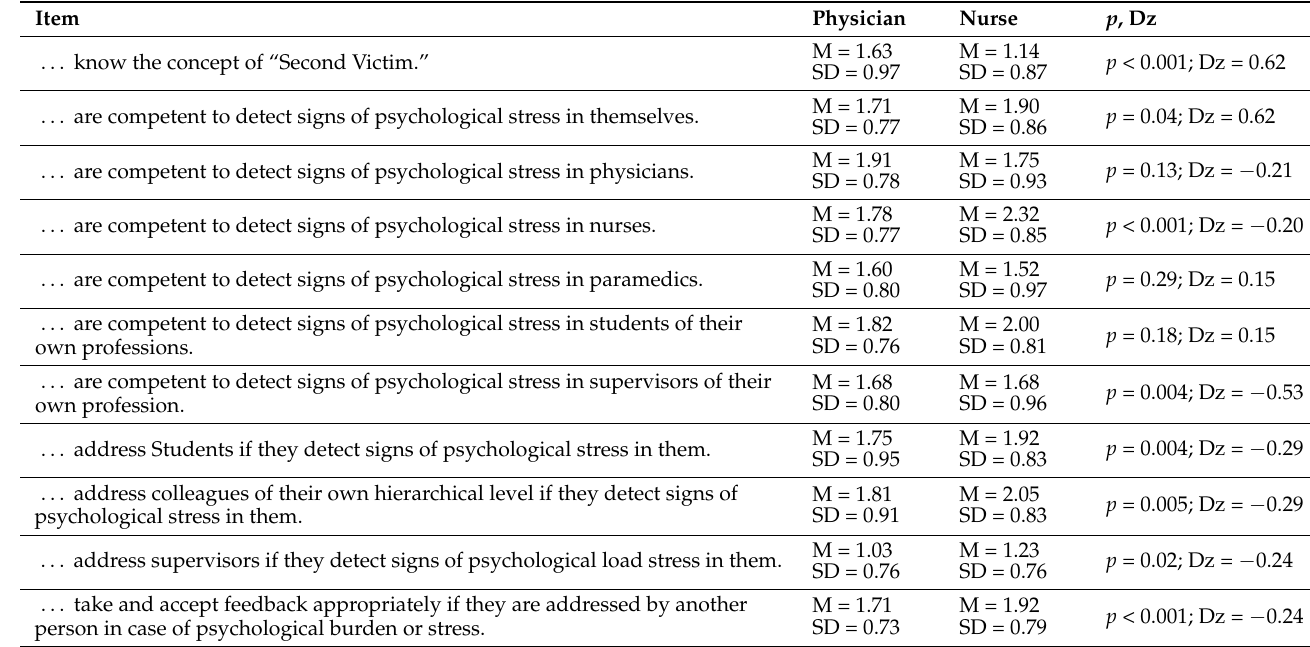
Table 2. Results of paired samples t-tests with bootstrapping (bias-corrected and accelerated (BCa) based on 1000 samples) of differences between the assessment of physicians’ and nurses’ competencies estimated by physicians.